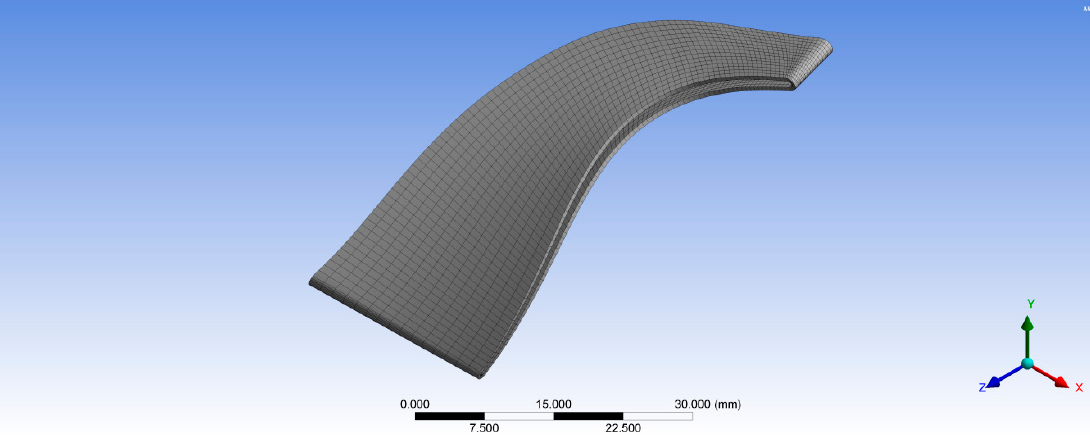
Figure 6. Three-dimensional structural mesh for the wheel turbine hub with 175,487 nodes.